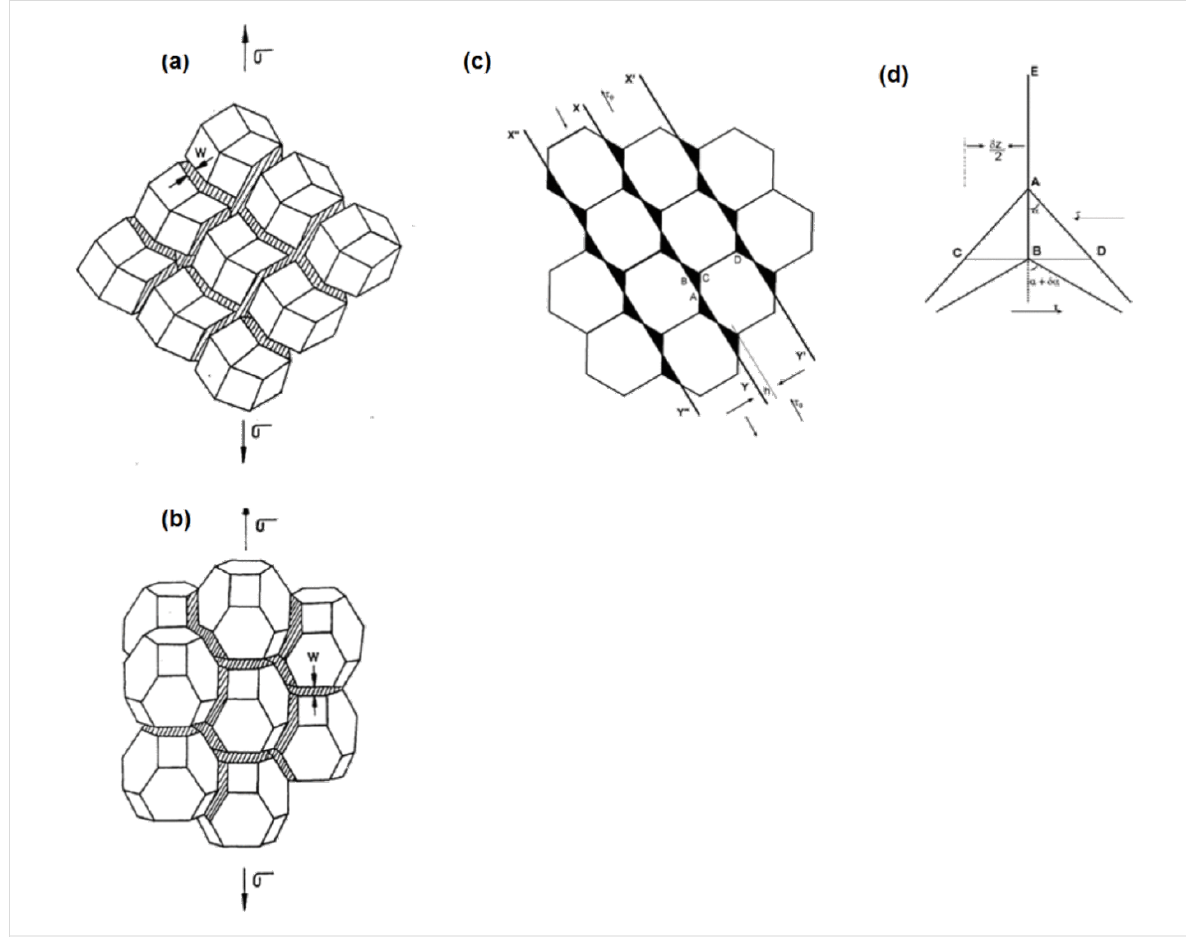
Figure 5: Development of mesoscopic grain/interphase boundary sliding. Shaded grain boundaries of rhombic dodecahedral (a) and tetrakai decahe- dral (b) grains within which the rate-determining process is confined. (c) Resulting planar interfaces (along XY, X’Y’, X”Y”, etc.), which are 2D sections of an aggregate of grains of equal size and rhombic dodecahedral shape. When the atoms located in the shaded regions are moved by the extension of the boundaries normal to the shear direction to reach the sliding boundary planes, a plane interface results. (d) Shear-stress driven movement of a boundary triple junction to lower the overall free energy of the system. (a) and (b) reproduced with permission from [54], Copyright 1996 Maney Publishing and (c) and (d) reproduced with permission from [56], Copyright 2004